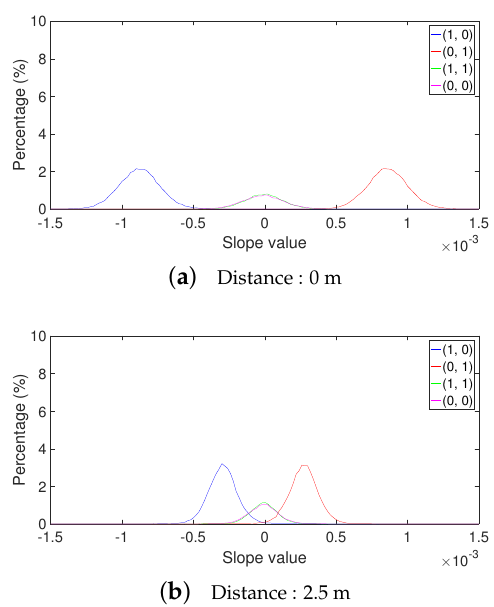
Figure 12. Distribution of slope values for different bit pairs at a bit rate of 200